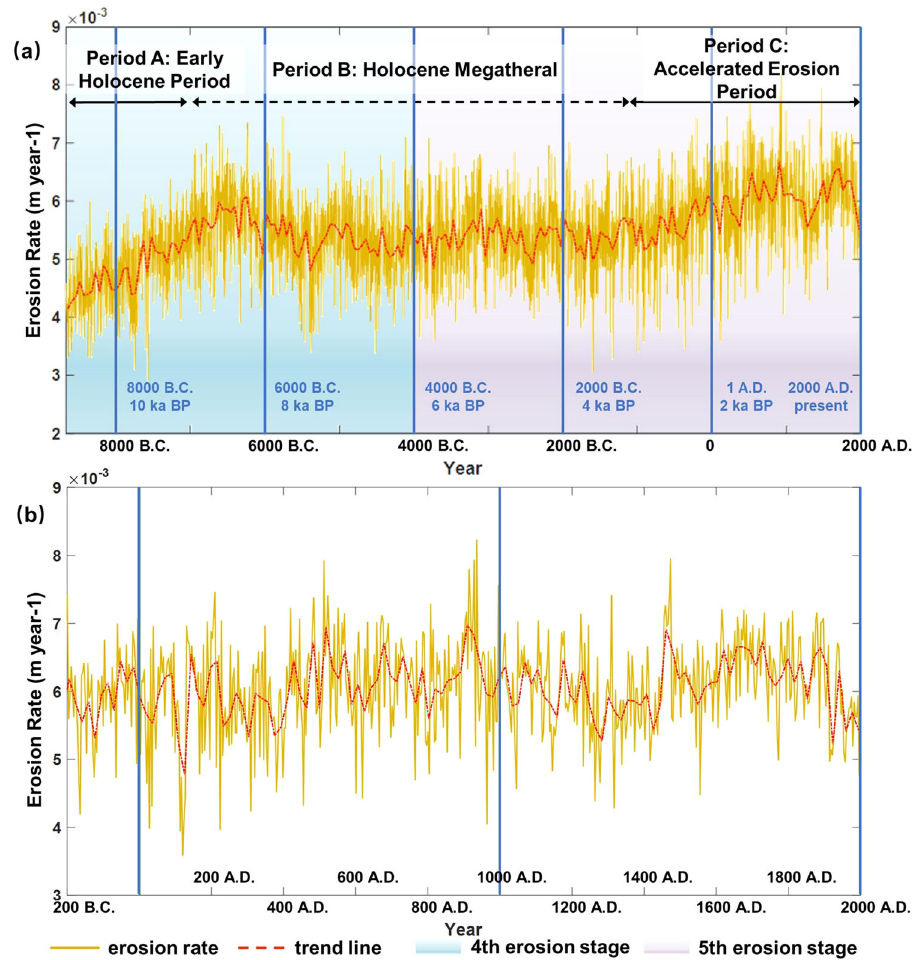
Fig. 4 Erosion rate curve of the archaeological city. a Erosion rate in the past 10 ka. The trend line was calculated with a moving average of 15 iterations (approximately 53.5 years). b Erosion rate in the past 2 ka. The trend line was calculated with a moving average of 3 iterations (~10.7 years). The coef fi cient of variation of erosion rates from 5000 B.C. to 3000 B.C. is 4.5%, which is less than that from 2000 B.C. to 0 (5.3%), which displays an obvious trend of slowly